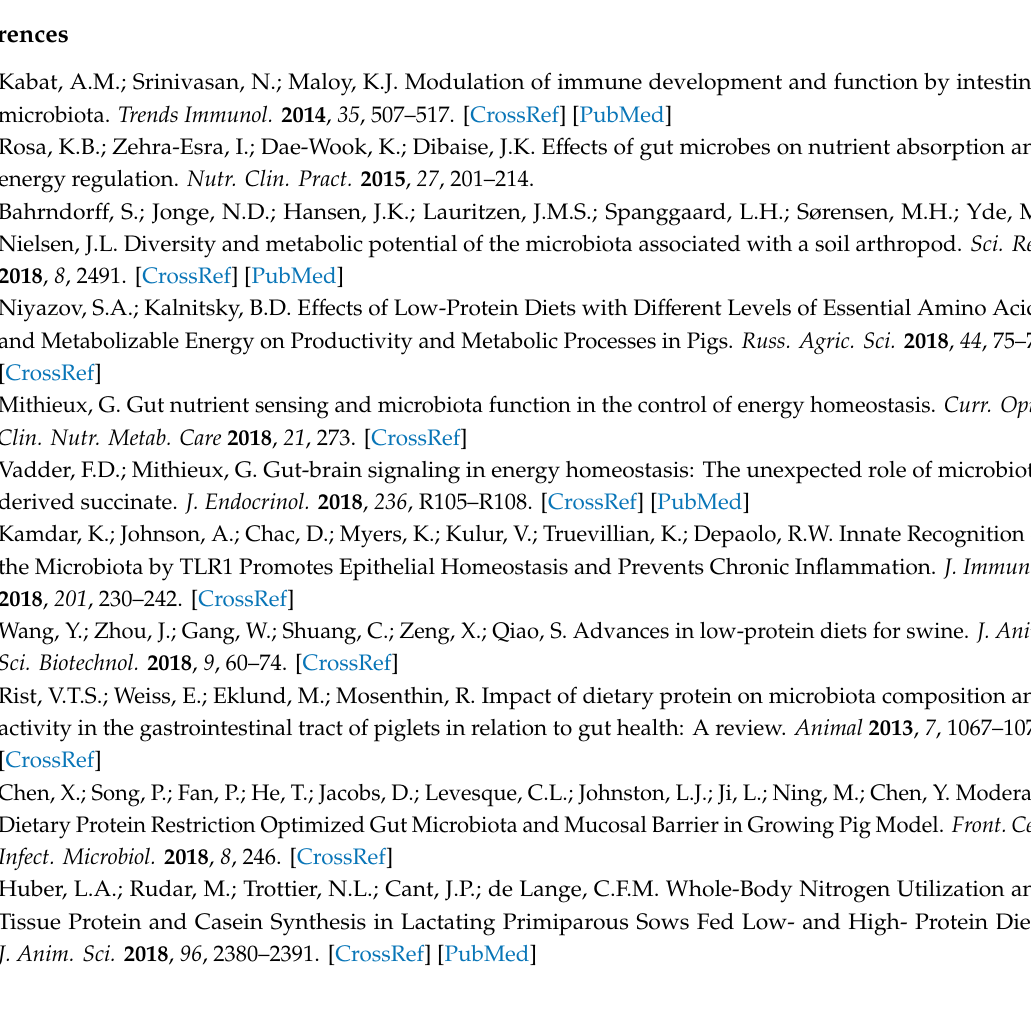
qPCR reaction programs. Supplementary Table S4. Sequencing data quality assessment. Supplementary Table S5: Species annotation and taxonomic analysis. Supplementary Table S6. Alpha diversity